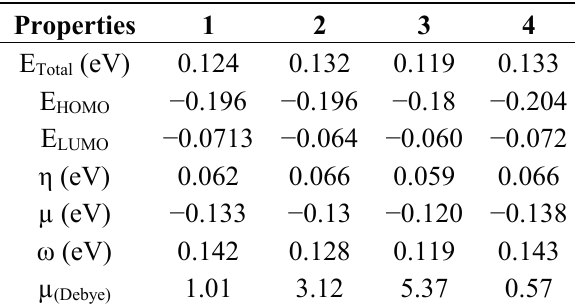
Table 12. Reactivity indices of compounds 1 – 4